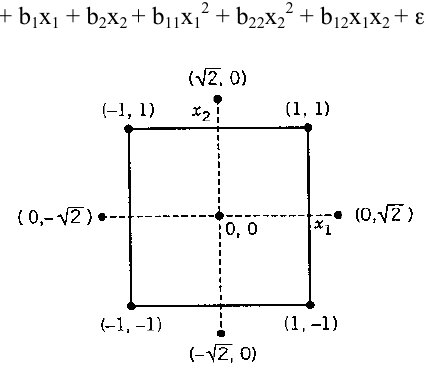
Fig. 18. Regime 448 A with Ar 92%/ CO